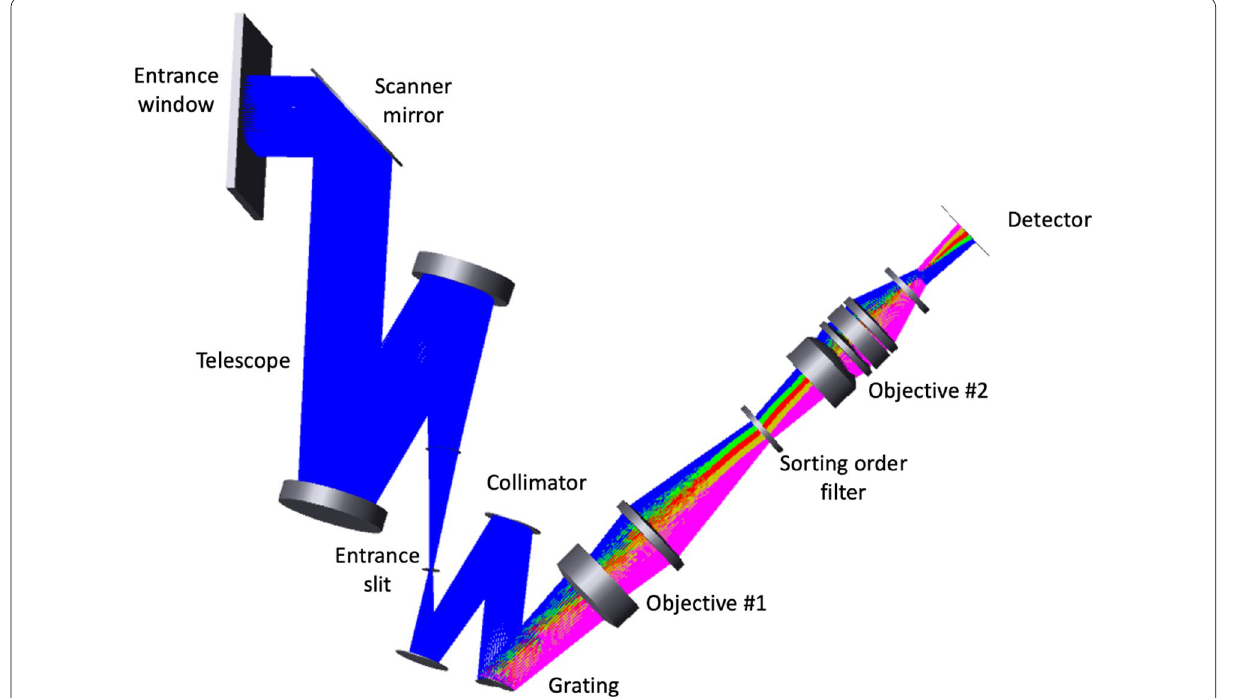
Fig. 5 MIRS optical design